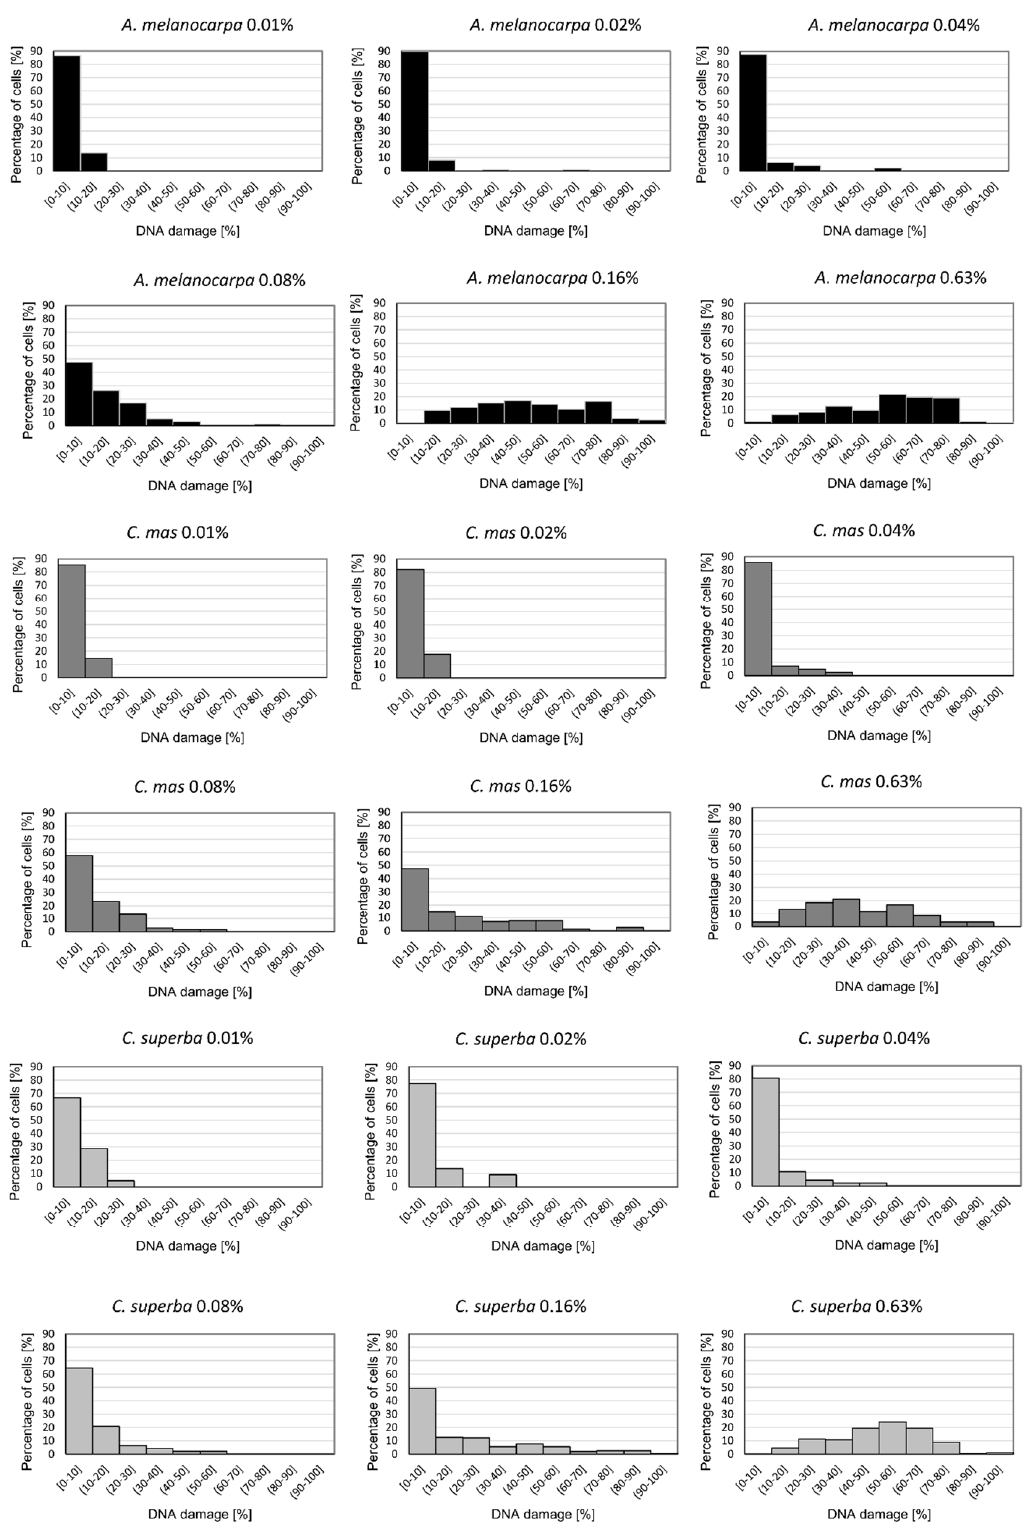
Figure 5. Histograms illustrating the distribution of endogenous DNA damage in Caco-2 cells exposed to Aronia melanocarpa , Cornus mas and Chaenomeles superba leaf extracts at concentrations of 0.01%, 0.02%, 0.04%, 0.08%, 0.16%, and 0.63%.